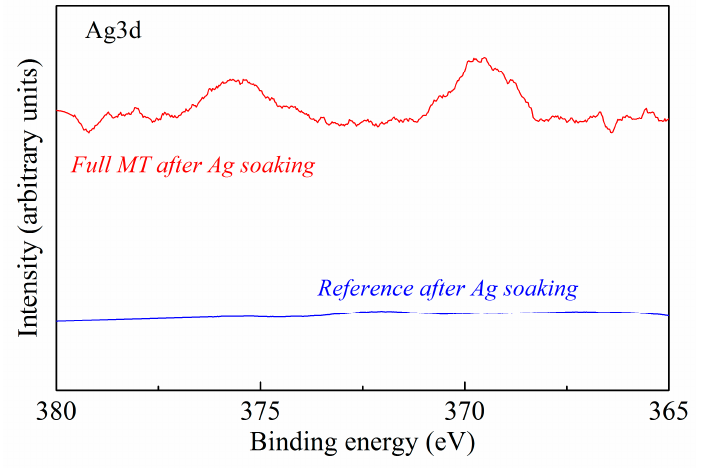
Figure 9. XPS spectra of Ag3d peak of the MT-coated SiO 2 after Ag soaking ( red line ) compared to the clean SiO 2 reference sample ( blue line ).